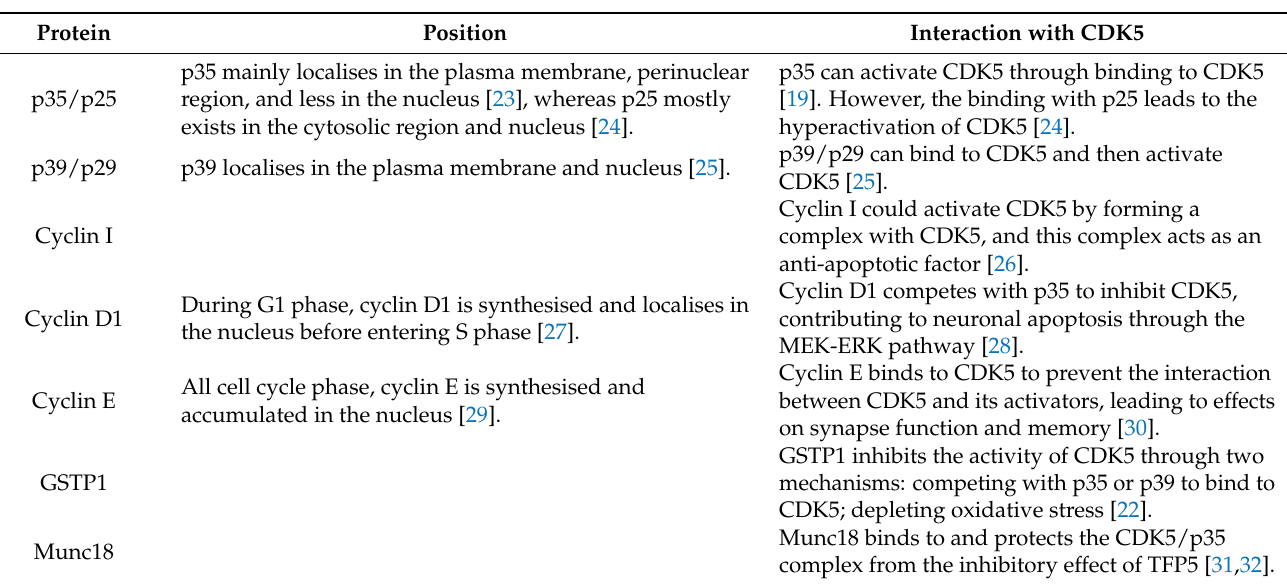
Table 1. The regulatory subunits of